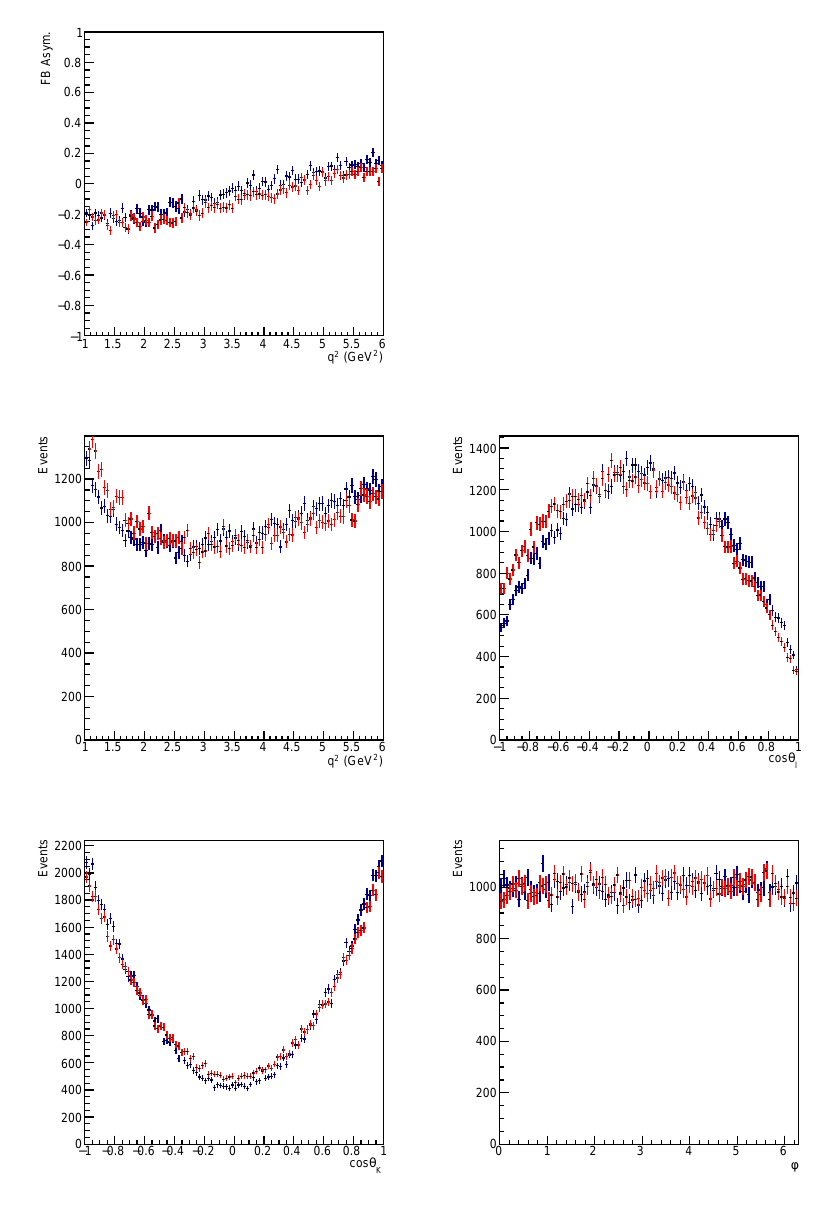
Figure 1. The forward-backward asymmetry, q 2 , cos θ l , cos θ K and φ distributions for ¯ B 0 → ¯ K ∗ 0 (cid:96) + (cid:96) − , ¯ K ∗ 0 → K − π + decays generated with the “EvtEOSLargeRecoil” model. The SM expectation is shown as red points and a possible new physics case in which C 9 and C 10 are modified by − 0 . 73 and + 0 . 40 is shown as blue